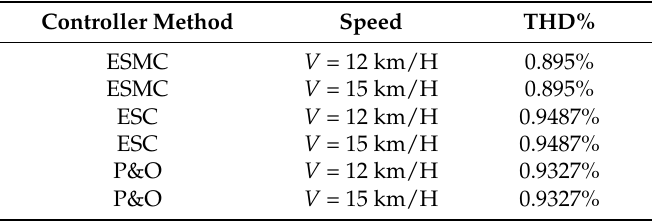
Table 3. Total harmonic distortion (THD) results for different speeds of the three control